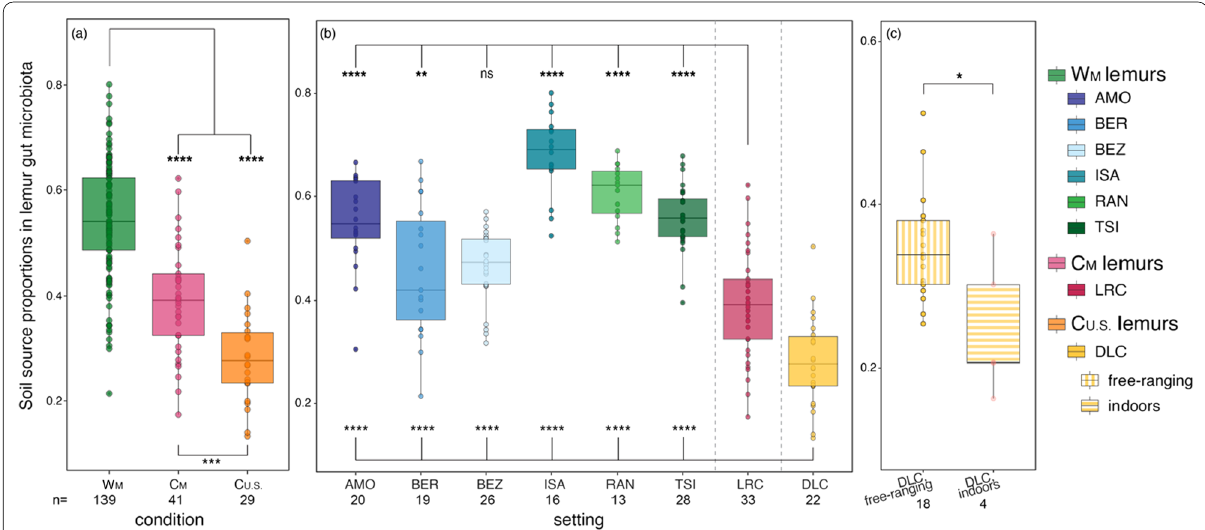
Fig. 8 Source proportions, calculated using probabilistic models in FEAST, for soil-associated microbes in the gut microbiota (GMB) of lemurs a collapsed by environmental condition: wilderness in Madagascar (W M ; green), captivity in Madagascar (C M ; pink), and captivity in the U.S. (C U.S. ; orange), b at each of the eight settings for which we had matched fecal and soil samples (reprising the color codes of each condition, delineated by dashed vertical lines), and c by housing status (i.e., semi-free-ranging in natural habitat enclosures or housed indoors) at the Duke Lemur Center (DLC). Tukey-style box and whiskers show the median (center horizontal line) and the interquartile range (upper and lower bounds of the box), with outliers that are 1.5 times less than the 25th quartile or 1.5 times more than the 75th quartile. Number of samples (n) is reported below each condition and setting. Kruskal–Wallis test with pairwise comparisons and Benjamini–Hochberg correction; * p < 0.05, ** p < 0.01, *** p < 0.001, **** p < 0.0001, ns